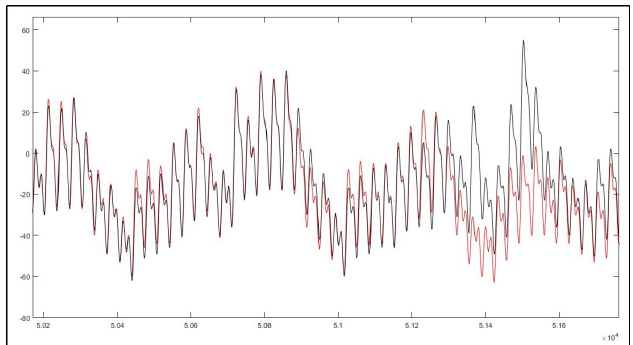
Figure 5. Overlapped power consumption trace of Figure 4a,b. The black line illustrates when the sign bit is 1 and the red line illustrates when the sign bit is